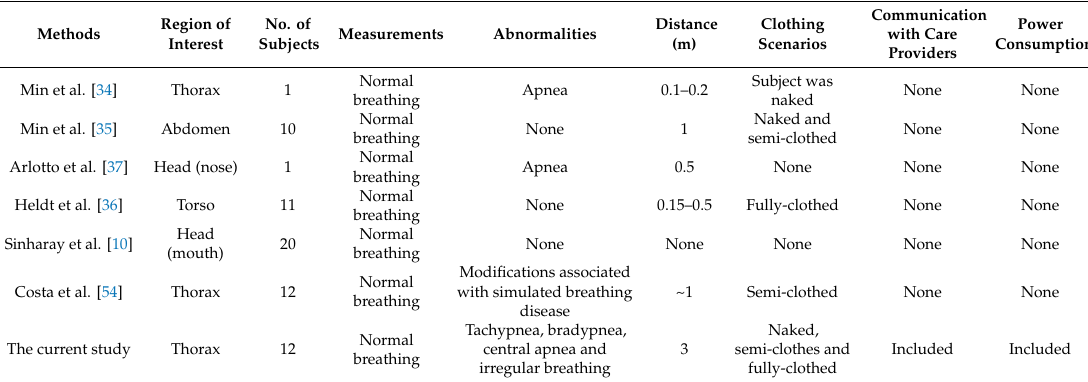
Table 1. Comparison with relevant